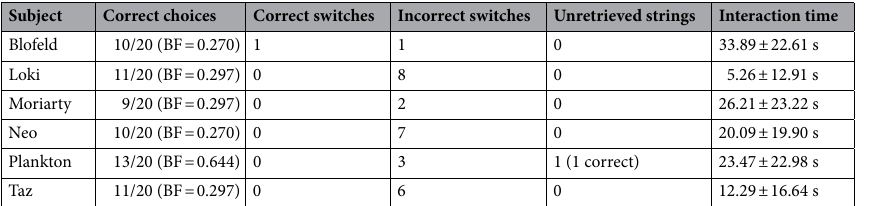
Table 4. Subjects’ performance in Experiment 3, with columns showing, in order: number of correct choices for the continuous string (Bayesian binomial test values in parentheses), number of times subjects first made a correct choice and then switched to the incorrect choice (counted as correct and ended the trial), number of times subjects made the incorrect choice and then switched to the correct choice (counted as incorrect and ended the trial), number of times subjects did not fully retrieve the chosen string from the apparatus, and average time spent interacting with